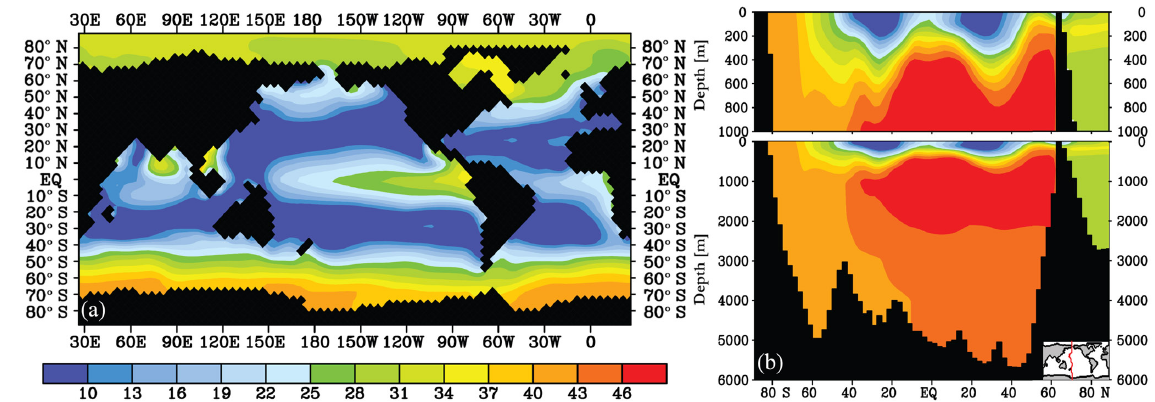
Figure 2. δ 13 C perc , the contribution of biology to the local δ 13 C signal (%), as calculated using Eq. (4) at (a) 25m depth and (b) a Pacific bio transect. The remainder of 100% is attributed to air–sea gas exchange. The δ 13 C bio and δ 13 C AS values in per mille are very similar to the values found by Schmittner et al.